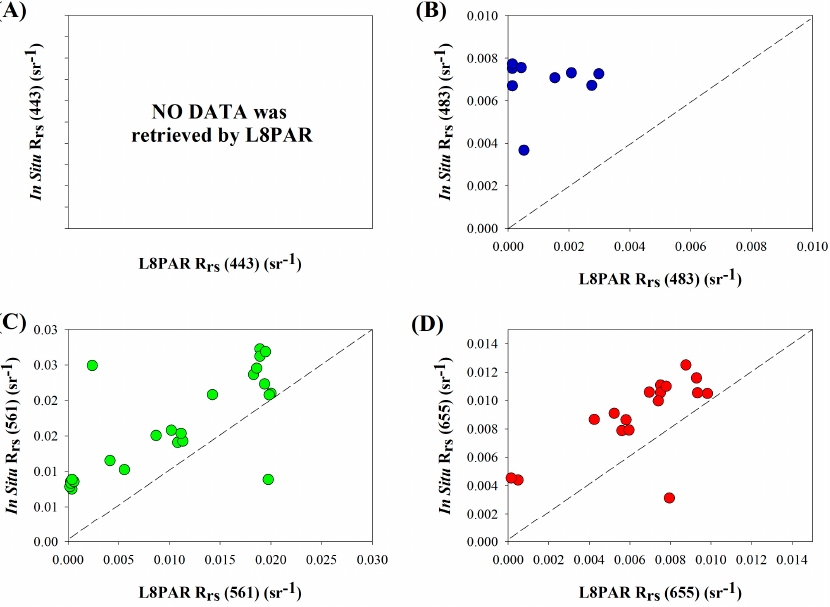
Figure 2. Relationship between L8PAR R rs values and in situ R rs values ( A ) band 1 (443 nm); ( B ) band 2 (483 nm); ( C ) band 3 (561 nm); and ( D ) band 4 (655 nm).